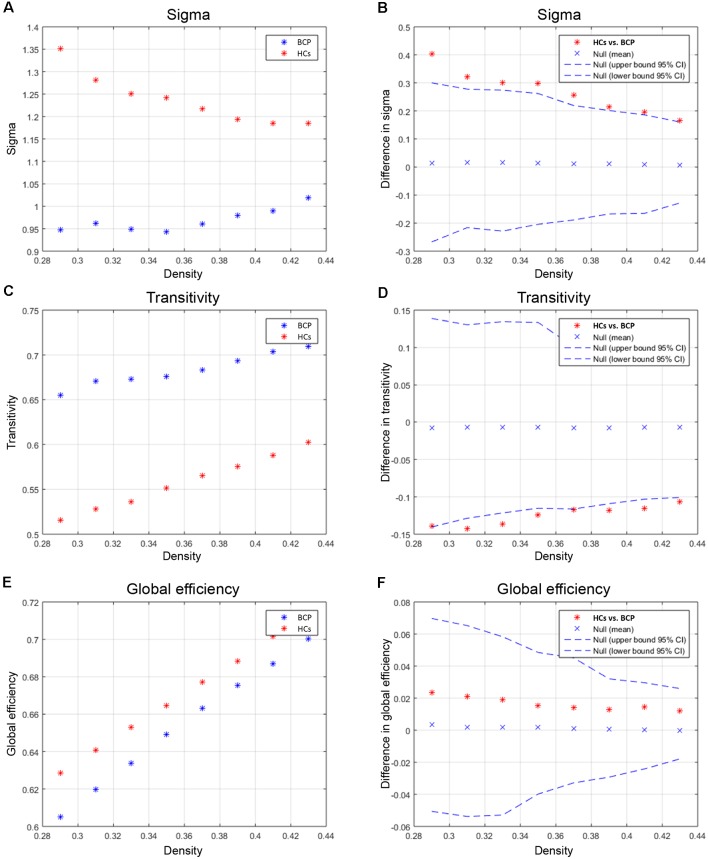
Between-group differences of global measures, sigma (A,B), transitivity (C,D) and global efficiency (E,F). There are significant between-group differences in sigma (B) and transitivity (D; p < 0.05, FDR-corrected). The value of sigma is lower in BCP group. The value of transitivity is higher in BCP group. BCP, bilateral cerebral palsy.